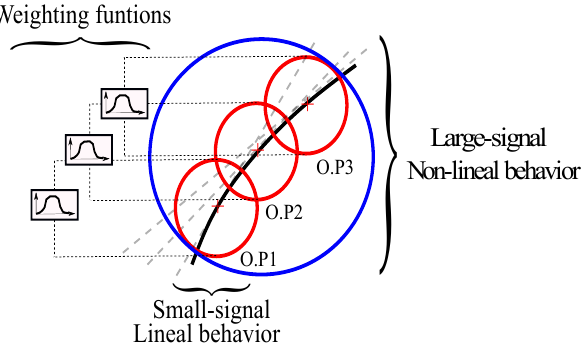
Figure A1. Graphic description of the large-signal